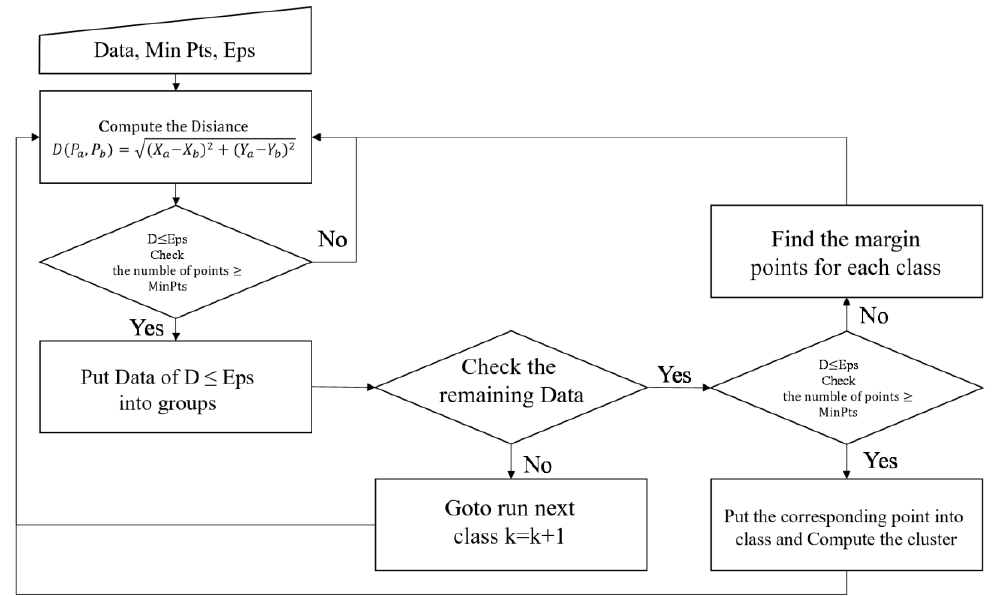
Figure 3. Steps for DBSCAN.